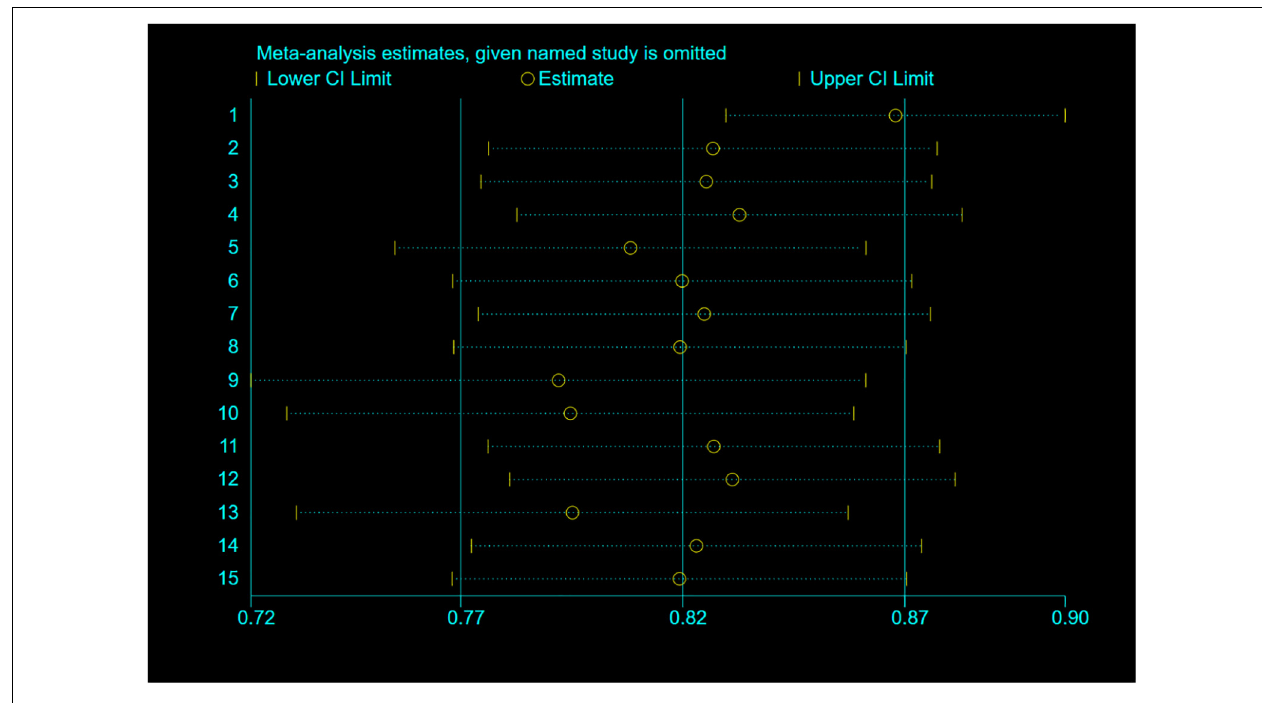
FIGURE 6 | Sensitivity analysis of therapeutic procedure success rate.